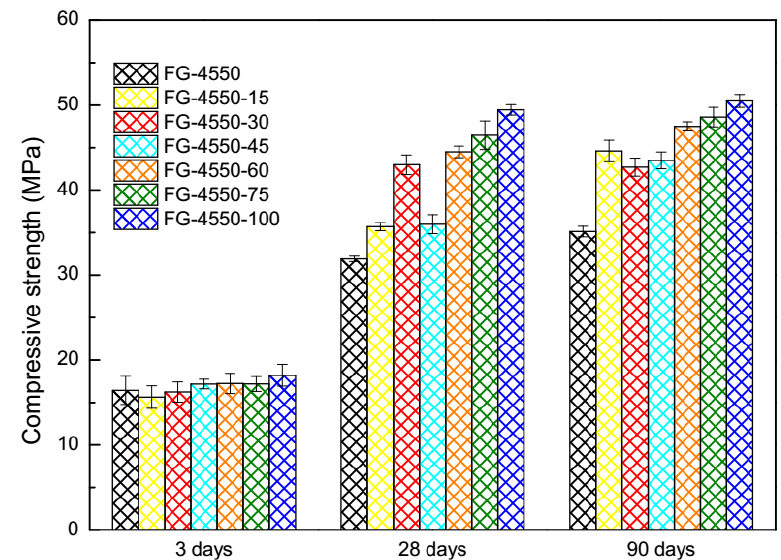
Figure 3. Compressive strength of FGD gypsum-based mortars replaced by S105-GGBS under normal curing conditions.